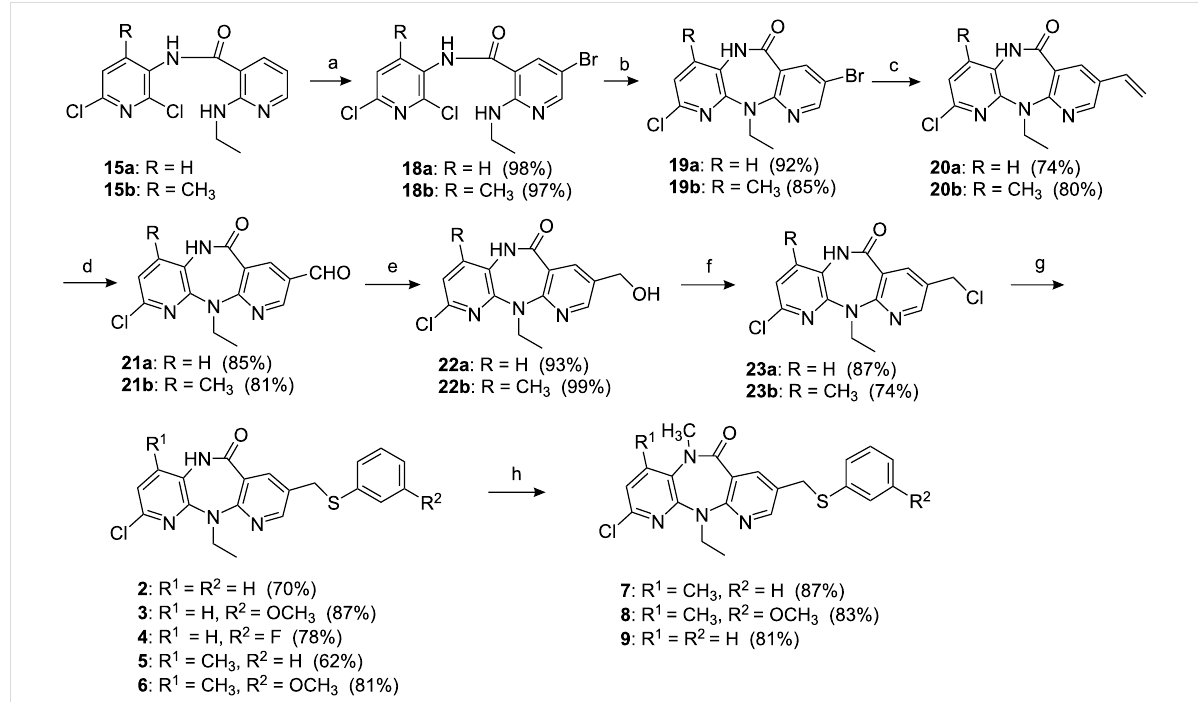
Scheme 2: Reagents and conditions: (a) Br 2 , HOAc, KOAc, rt, 1 h; (b) NaHMDS, pyridine, 90 °C, 1 h; (c) CH 2 =CH–SnBu 3 , Pd(PPh 3 ) 4 , DMF, 90 °C, 1 h; (d) O 3 , CH 2 Cl 2 /MeOH, −78 °C then PPh 3 , rt, 1 h; (e) NaBH 4 , THF, H 2 O, rt, 0.5 h; (f) SOCl 2 , CH 2 Cl 2 , Et 3 N, rt; (g) NaH, ArSH, DMF, rt, 1 h; (h) NaH, DMF, 50 °C, 0.5 h then MeI, rt, 0.5 h.